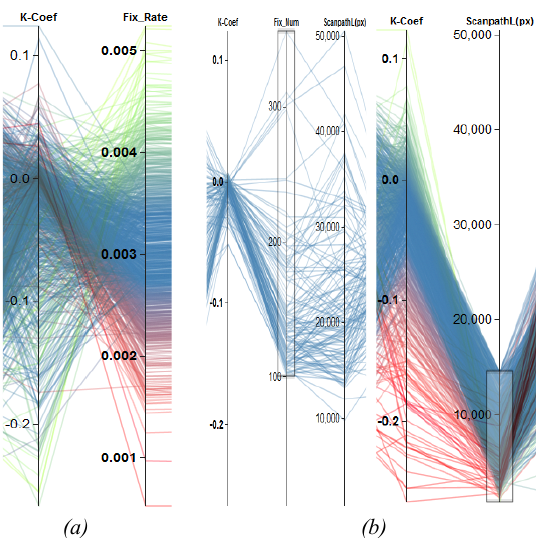
Figure 9. Separation of participants into two different groups of behavior regarding the Ҡ Coef based on the number of fixations. (a) shows all subjects with more than 100 fixations. They lead to Ҡ Coef values centered around zero. Fewer fixations result in a broader negative distribu- tion, which is shown in (b). This achieves about the same separation as utilizing the scanpath length with a thresh- old of about 15.000 px.